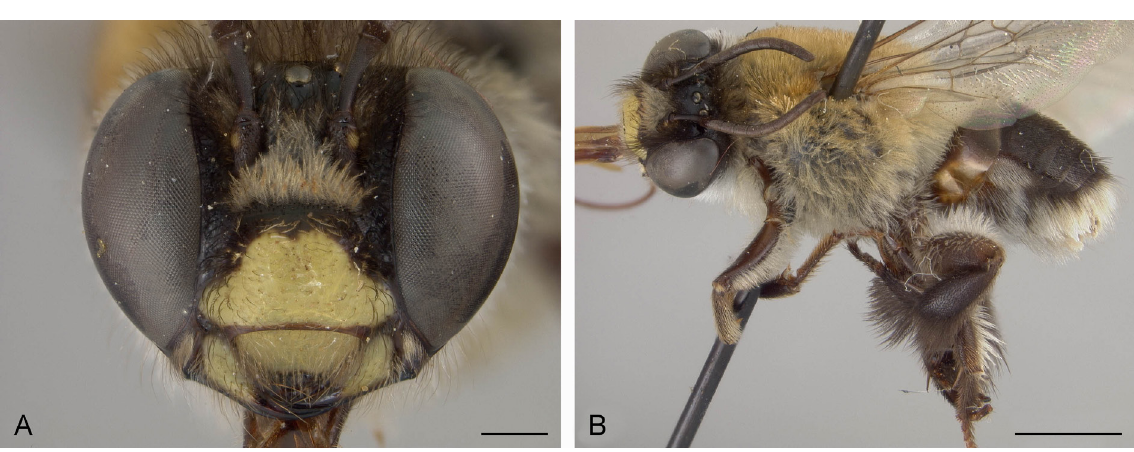
Fig. 15. Centris durantae Cockerell, 1949, holotype, ♂ (NMNH; USNM ENT 00534198). A . Frontal view. B . Habitus, lateral view. Scale bars: A = 1 mm; B = 2